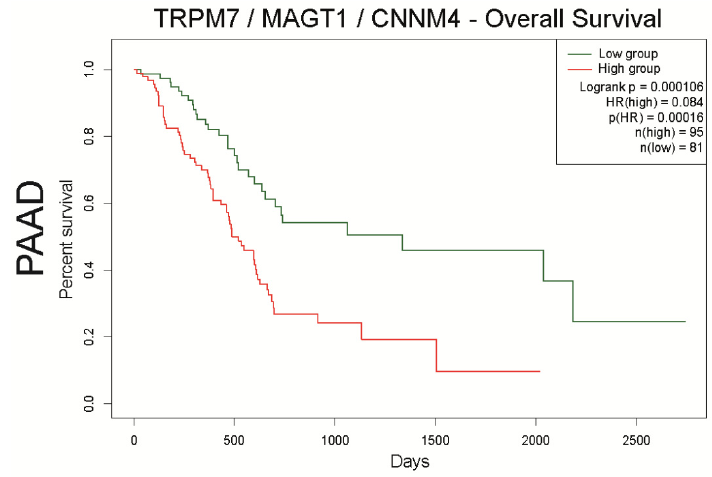
Figure 7. Analysis of overall survival of the TRPM7/MAGT1/CNNM4 signature in pancreatic cancer datasets using SurvExpress. PAAD patients were stratified using a gene signature combining TRPM7, MAGT1, and CNNM4. Kaplan–Meier curves were analyzed using the optimized SurvExpress Maximize algorithm. The number of analyzed patients across time (days) is indicated below the horizontal axis for both conditions, as previously described [86].